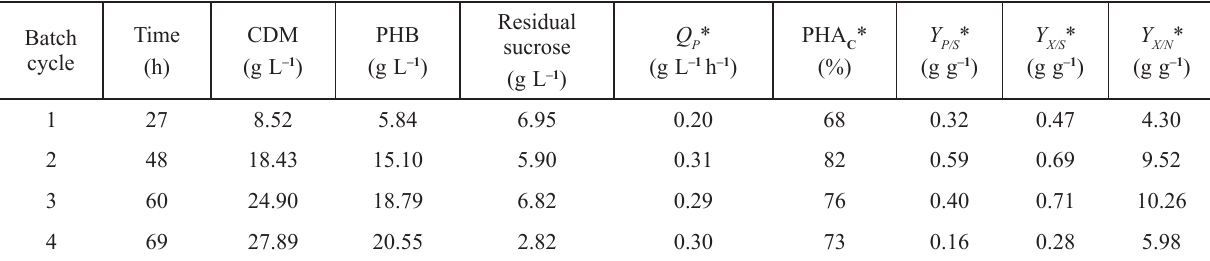
Table 2 – Growth and product kinetic parameters of A. australica during repeated-batch fermentation Batch cycle